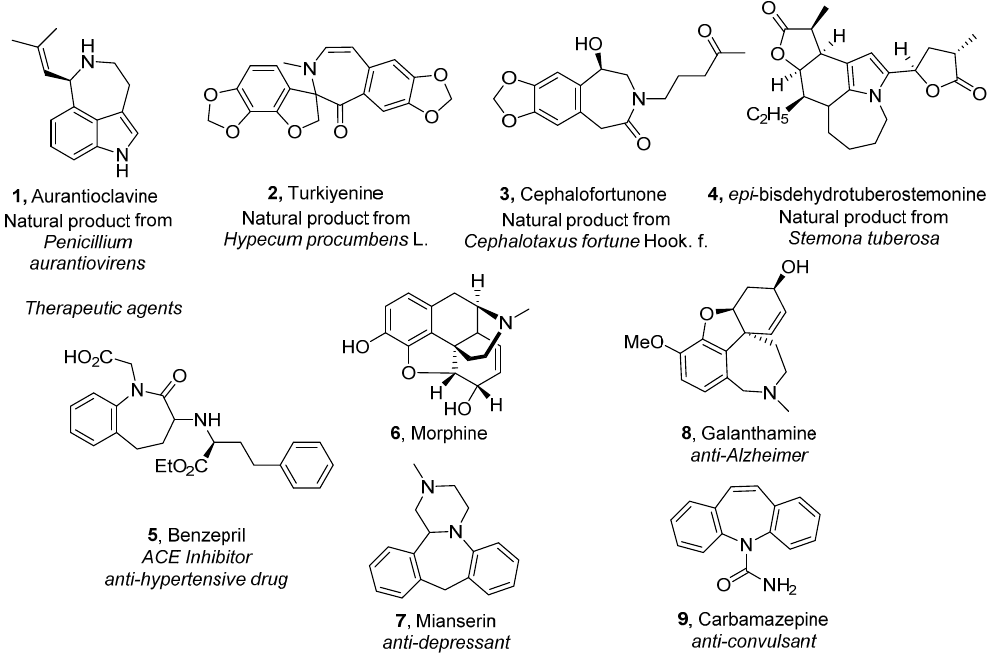
Figure 1. Representative examples of bioactive benzazepines.